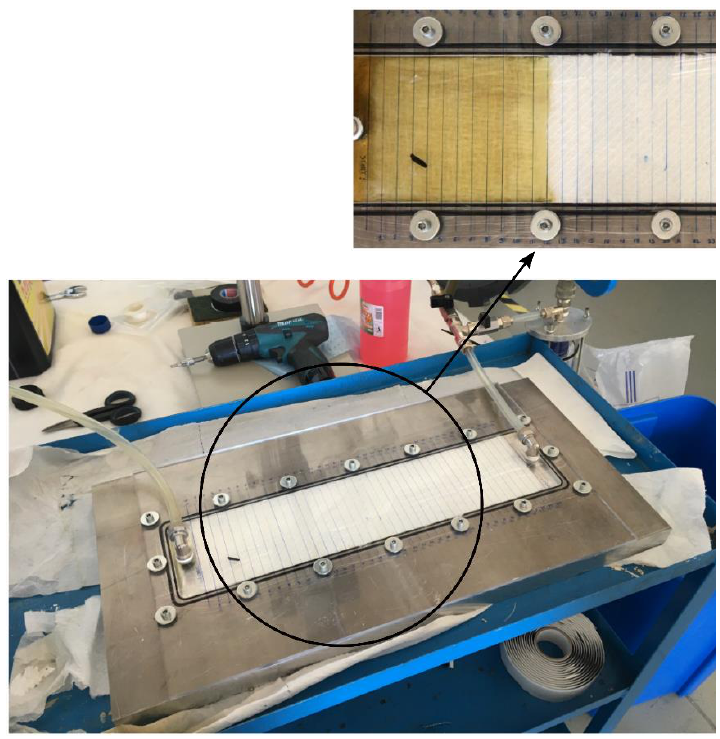
Figure 1. Linear flow test bench used for measurement of glass textile permeability. The oil flow front is clearly visible in the detailed view.